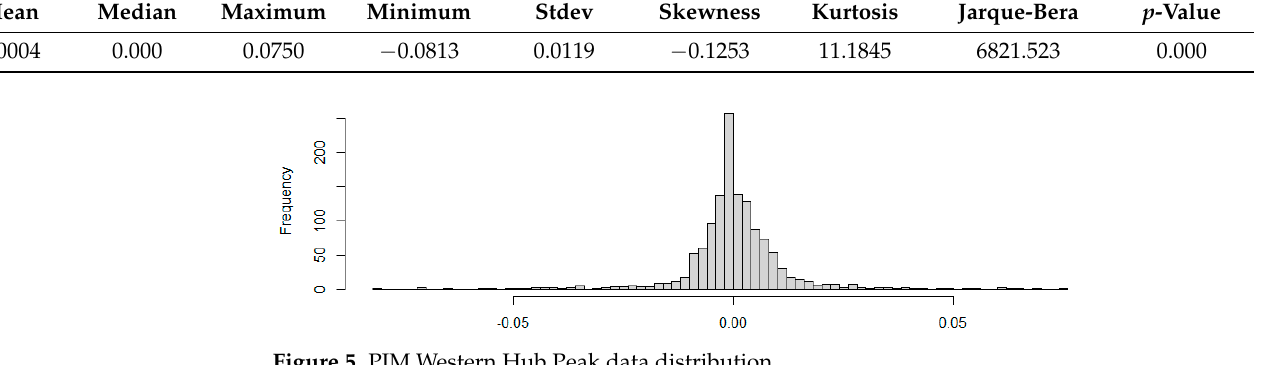
Figure 5. PJM Western Hub Peak data distribution.